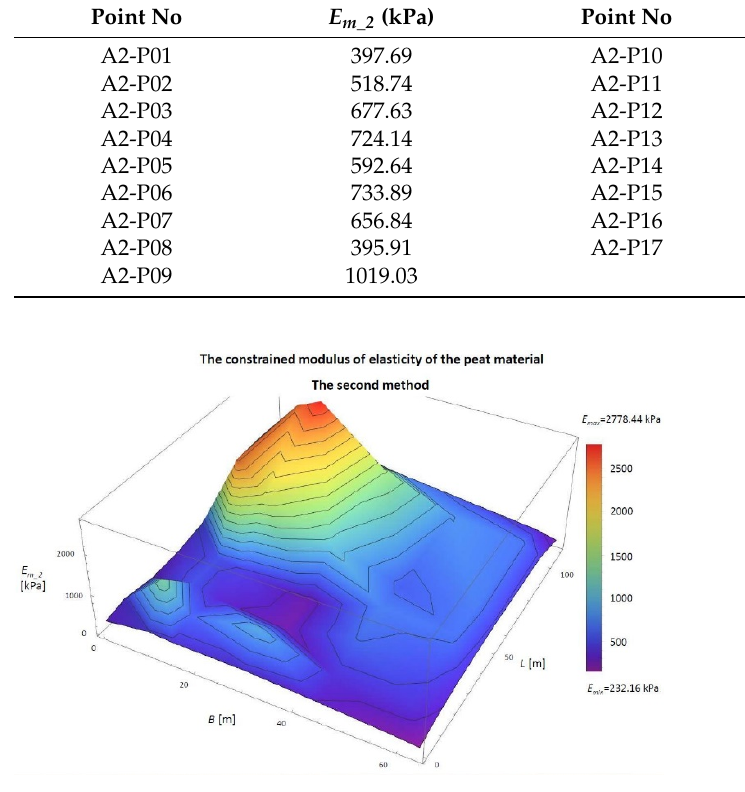
Figure 19. The second method is the value of the constrained modulus of elasticity under the embankment in Szczecin on the Ostrów Brdowski island. embankment in Szczecin on the Ostr ó w Brdowski